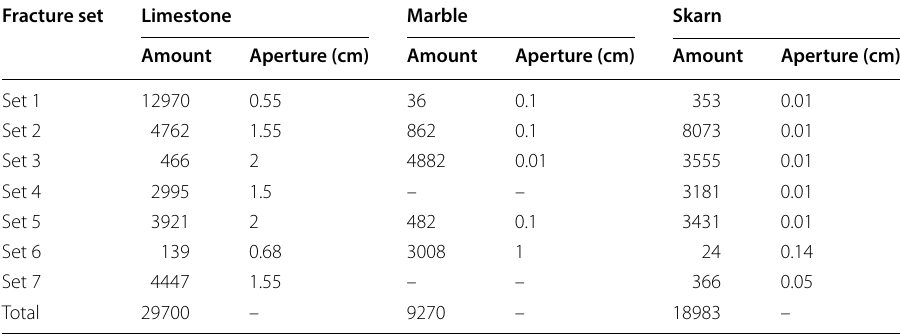
Table 2 Fracture numbers, and initial apertures per fracture sets and per formation Fracture